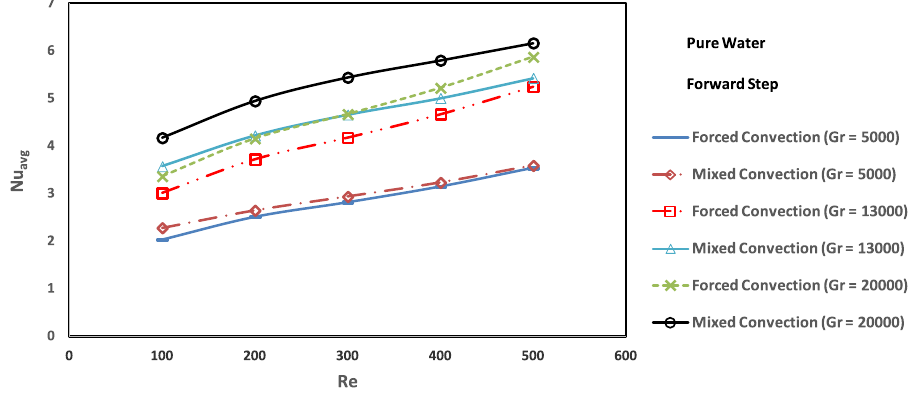
Fig. 7 Average Nusselt number at different Reynolds number for forced and mixed convec- tion types of pure water in for- ward step at different Grashof